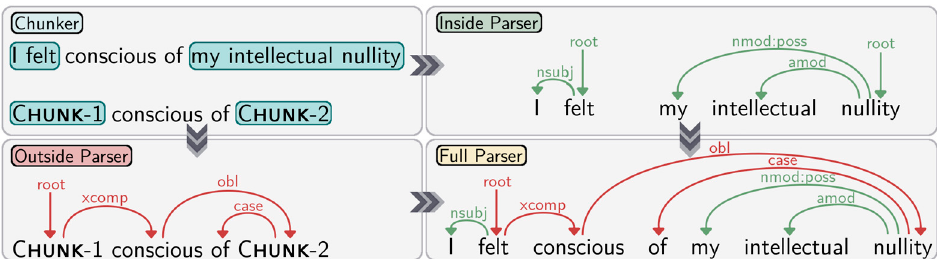
Figure 1. Initially the sentence is processed by the chunker. The contents of the chunks are then sent to the inside parser and the abstract representation of the sentence is sent to the outside parser. The predictions from both are then collated to form the full